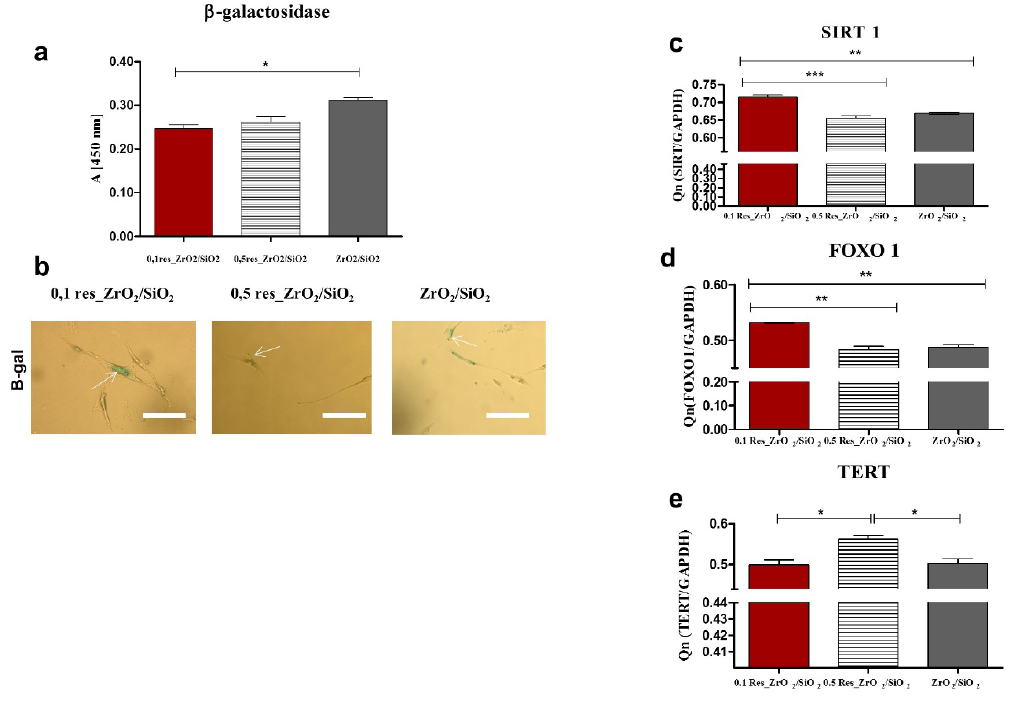
Figure 8: Quantification of beta-galactosidase staining performed at wavelength of 450 nm (a) and pictures took under brightfield microscope showing the accumulation of blue dye (b). Expression levels of the SIRT 1 (c), FOXO 1 (d) and TERT genes (e) in order to assess aging of cells. Magnification: x100. Results expressed as mean ± SD *pvalue<0.05,. **pvalue<0.01, ***pvalue<0.001. Scale bar 200